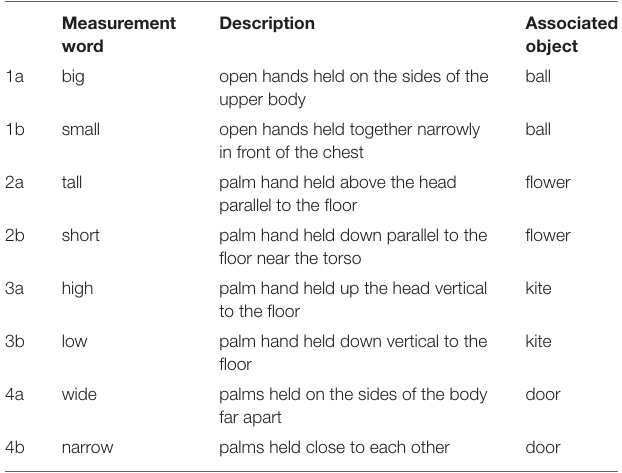
TABLE 1 | Iconic gestures produced for each word and associated